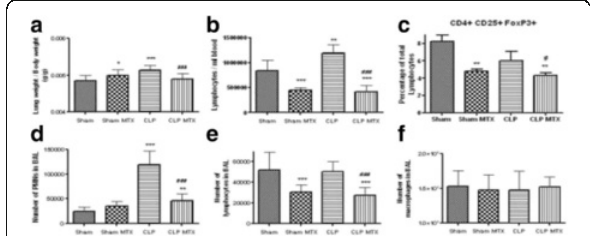
Fig. 54 (abstract A138). (A) Lung relative weight (B) Lymphocytes per ml of blood (C) Percentrage of Treg Lymphocytes (characterized by the expression of CD4, CD25, FoxP3 markers). (D)(E)(F) Total number of PMNs, Lymphocytes and Macrophages present in broncoalveolar lavage (BAL). All values are represented as mean ±SEM. *p<0.05 vs Sham and #p<0.05 vs CLP. **/## p<0.01, ***/### p<0.001 (Sham and Tham MTX n=13, CLP and CLP MTX n=17)